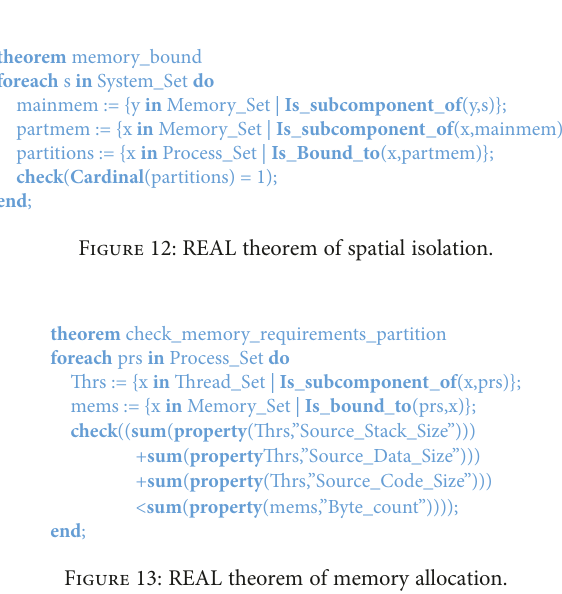
Figure 11: REAL theorem of partition time